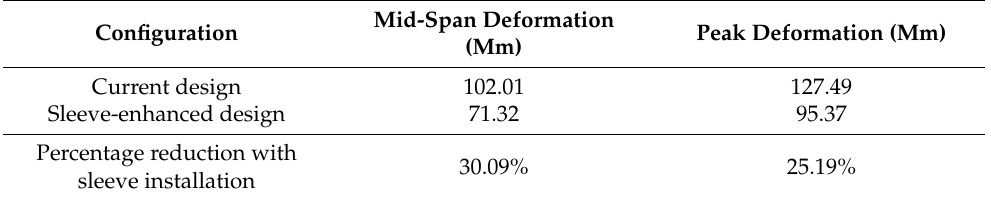
Table 8. Deformation results of both composite cross arm configurations. Reproduce from Ref. [2].